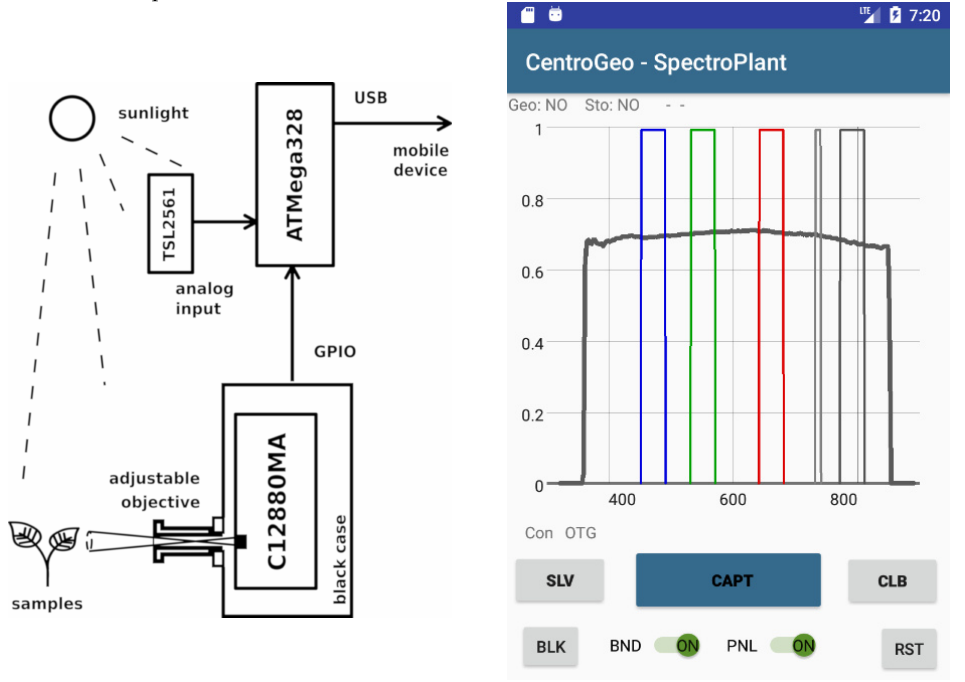
Figure 2. Portable spectrometer with mobile device